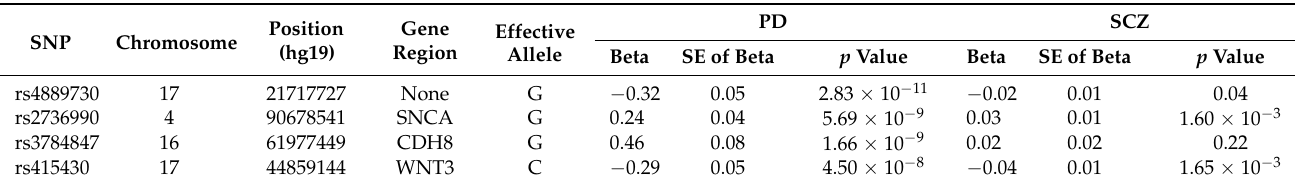
Table 1. List of the SNPs associated with risk for Parkinson’s disease (PD) and their associations with risk for schizophrenia (SCZ).